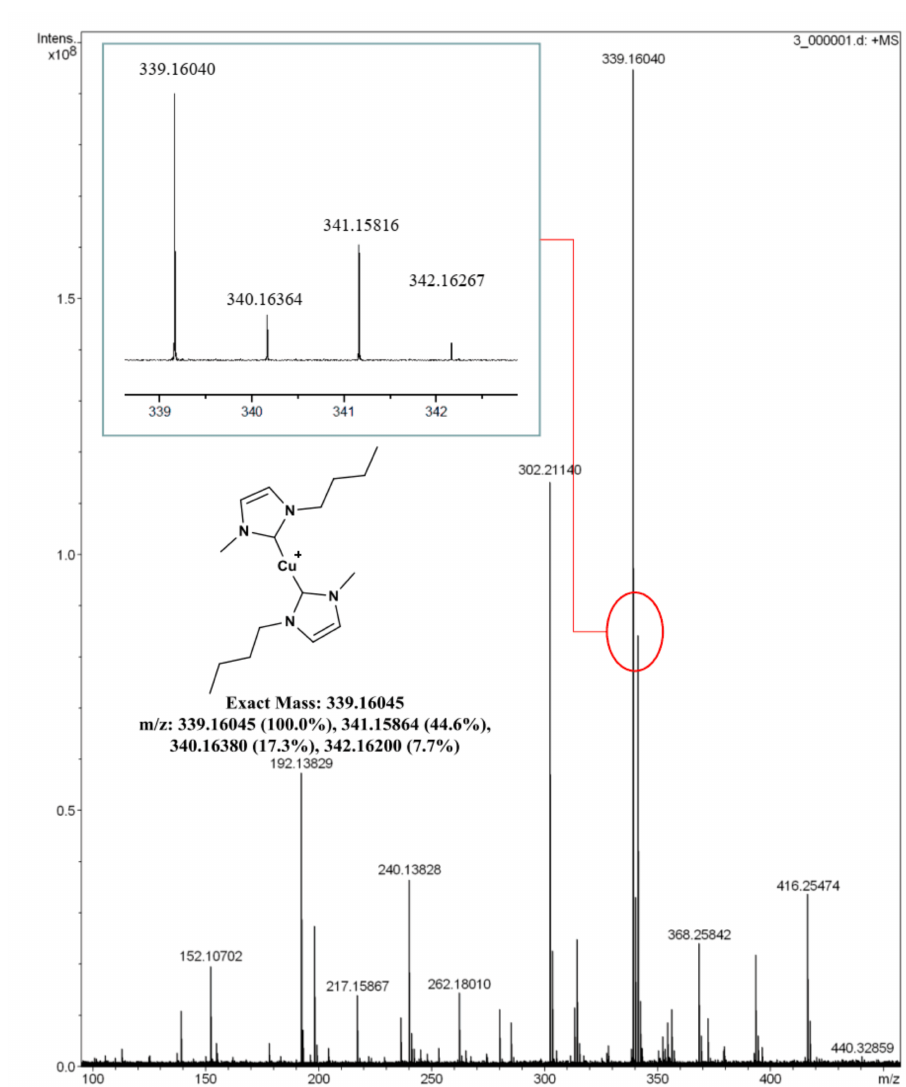
Figure 3. High-Resolution Mass Spectrum of the system of reaction